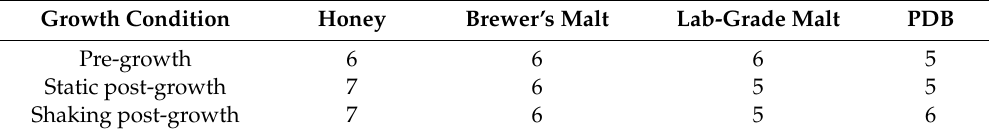
Table 1. pH of liquid media before and after Chlorociboria growth.